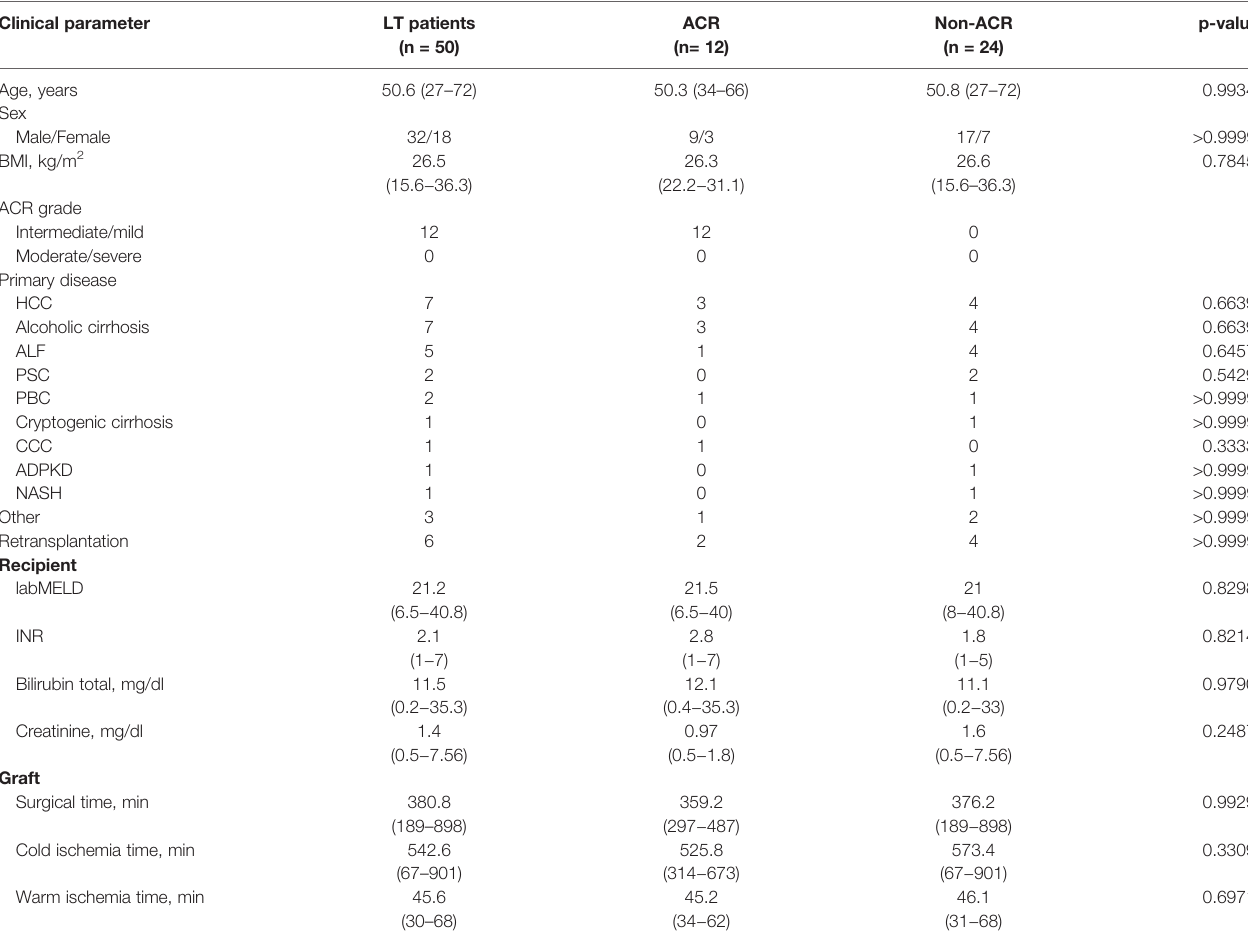
TABLE 1 | Baseline characteristics of study cohort. Listed laboratory results were determined before transplantation. Clinical parameter